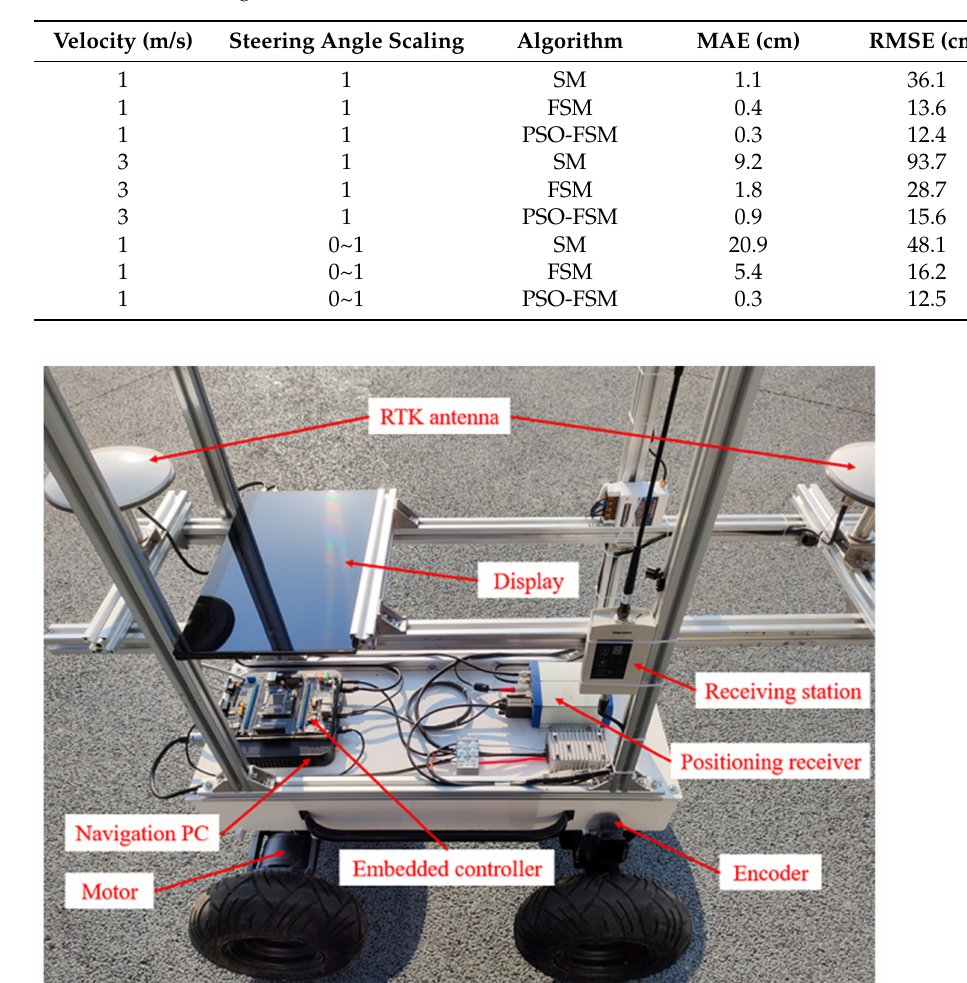
Figure 8. Setup for mobile vehicle path tracking